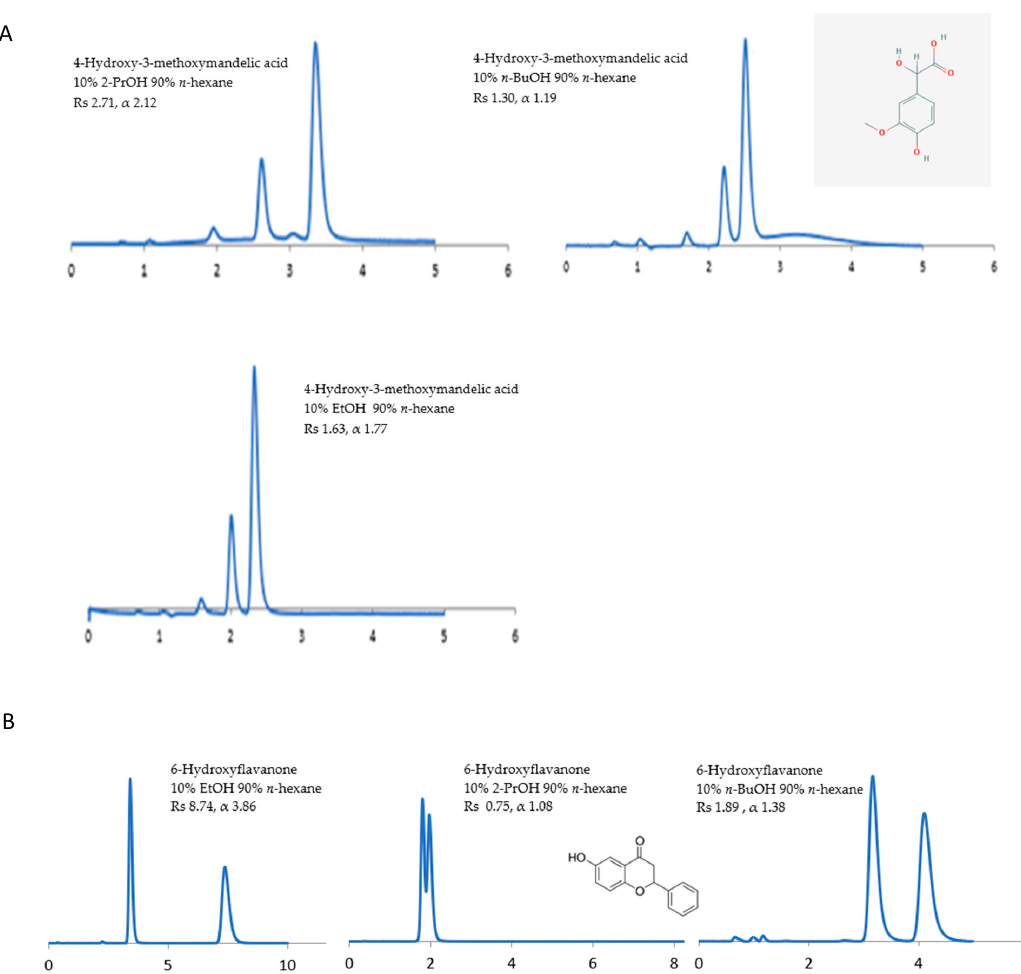
Figure 1. The effect of different alcohol modifiers: 2-propanol (2-PrOH), ethanol (EtOH), and n -butanol ( n -BuOH) on enantioselectivity under two sub-2-micron chiral stationary phases. ( A ) The effect of different alcohol modifiers on 4-hydroxy-3-methoxymandelic acid using Chiralpak ® ID-U. ( B ) The effect of different alcohol modifiers on 6-hydroxyflavanone using Chiralpak ® IG-U. Previous studies have showed improvements in selectivity with n- heptane over n- hexane [26,27]. Therefore, in the current study, n -hexane was replaced with n -heptane. For example, flavonoids (6-hydroxyflavanone and flavanone) using Chiralpak ® ID-U showed an enhanced Rs and α under n -heptane. As shown in Figure 2, flavanone showed an enhanced Rs 2.14 and α 1.99 under n -heptane/ n -BuOH (90/10, v/v ) compared to Rs 1.17 and α 1.74 under n -hexane/ n -BuOH (90/10, v/v ). The effect of different alcohol modifiers used on Chiralpak ® IG-U expressed a range of results in the transition between n- hexane to n -heptane. For example, chlorpheniramine showed an enhanced Rs which increased from 1.74 to 2.33 and an α which increased from 1.55 to 1.97 using n -heptane.